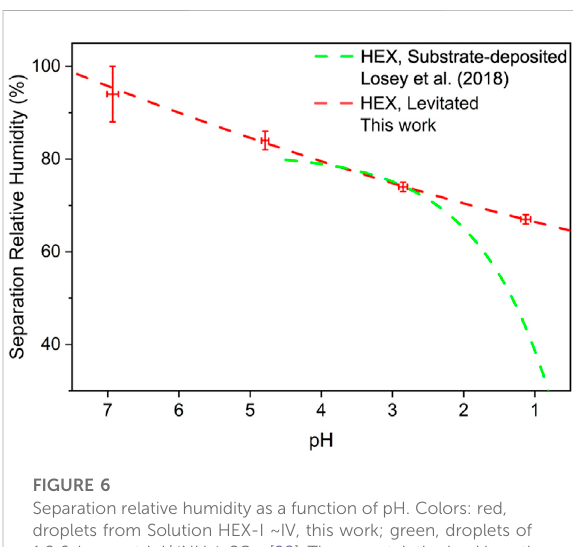
FIGURE 6 Separation relative humidity as a function of pH. Colors: red, droplets from Solution HEX-I ~IV, this work; green, droplets of 1,2,6-hexanetriol/ ( NH 4 ) 2 SO 4 , [28]. The uncertainties in pH are the standard deviations resulting from averaging multiple measurements. The uncertainties in SRH mean the range where the exact values of SRH locate. The data points are the mediate values of the SRH